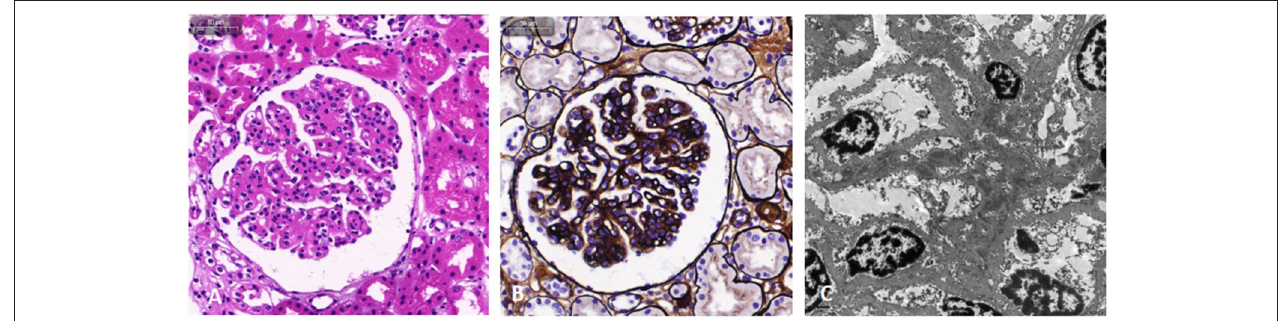
FIGURE 3 | Light microscopy and electron microscopy images of kidney involvement. Hematoxylin and eosin stain (A) and Jones silver stain (B) are light microscopy images. The mesangial and endothelial cells exhibit diffuse proliferation. The capillaries are narrow, the capillary loop slightly thickened, and a “dual-track” sign can be partially observed. In addition, epithelial cells of the renal tubule exhibit granule denaturation while there was no obvious atrophy of renal tubules and no interstitial fibrosis. (C) Electron microscopy image. Electron dense deposits were observed in the mesangial and deputy mesangial regions, as well as a small amount of electron-dense deposit in the